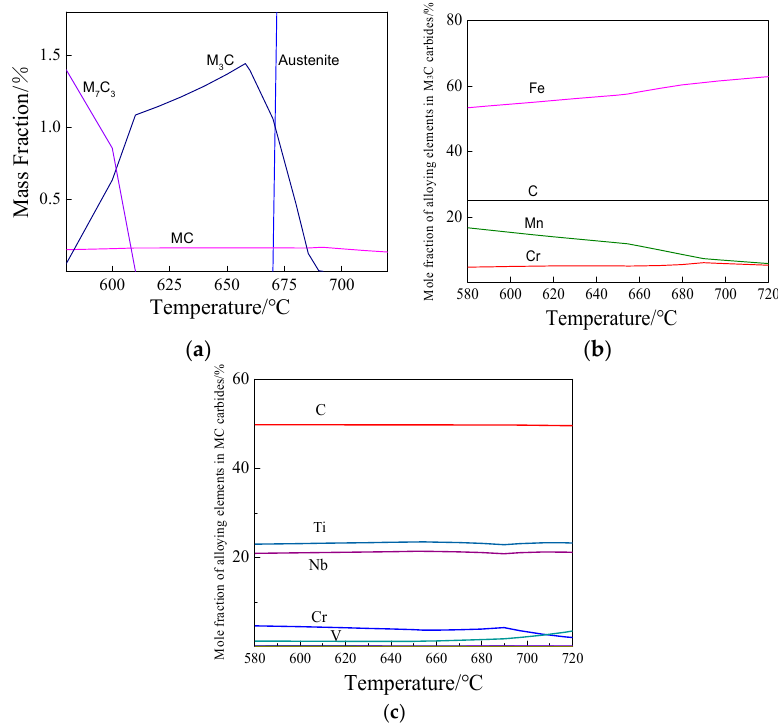
Figure 6. Thermodynamic calculation of the second phase particles. ( a ) The second phase precipitates in the tempering temperature range; ( b ) the composition of the M3C; ( c ) the composition of the MC.